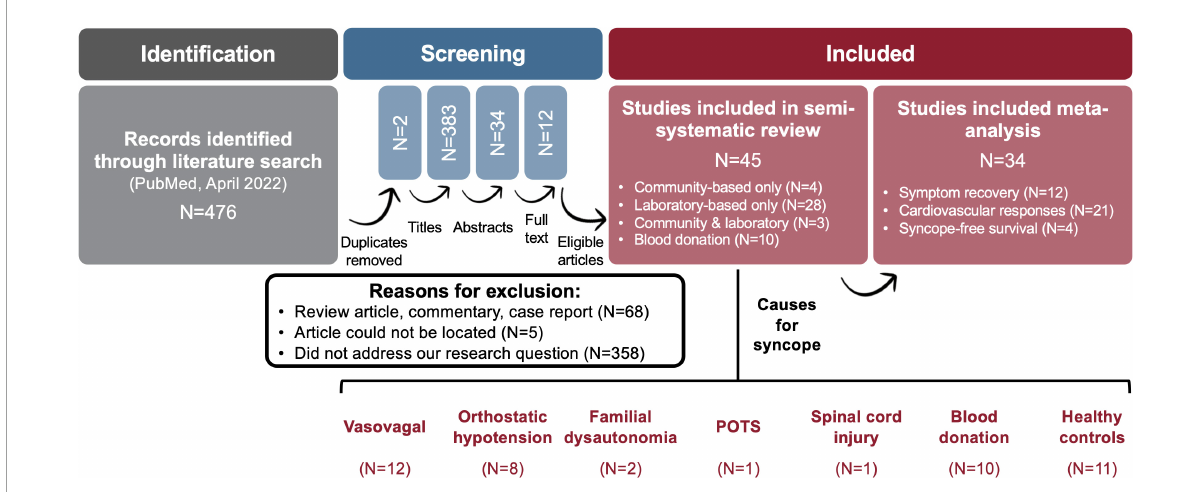
FIGURE3 Semi-systematic method for literature review. The above flow diagram depicts our article selection process. Articles were screened at various levels (titles, abstracts, full text) to identify those that were relevant. Works were included if they evaluated the role of counter pressure and other lower body maneuvers in preventing syncope. Articles were selected for meta-analysis based on common themes amongst the article pool. Articles identified for our review that did not evaluate outcomes considered for meta-analysis were discussed in narrative form. POTS, postural orthostatic tachycardia syndrome.